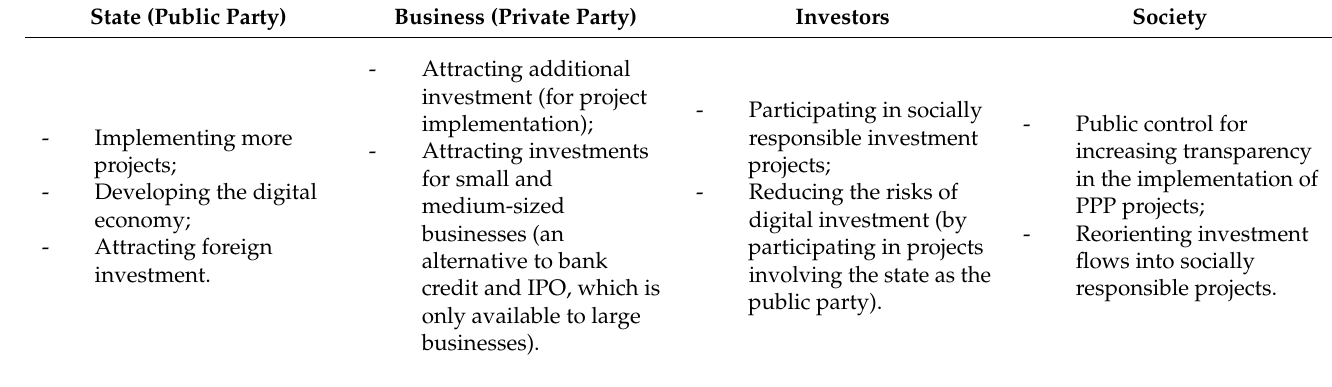
Table 7. Advantages (benefits) of digital investment tools for (participants, implementation) of public-private partner- ship projects.